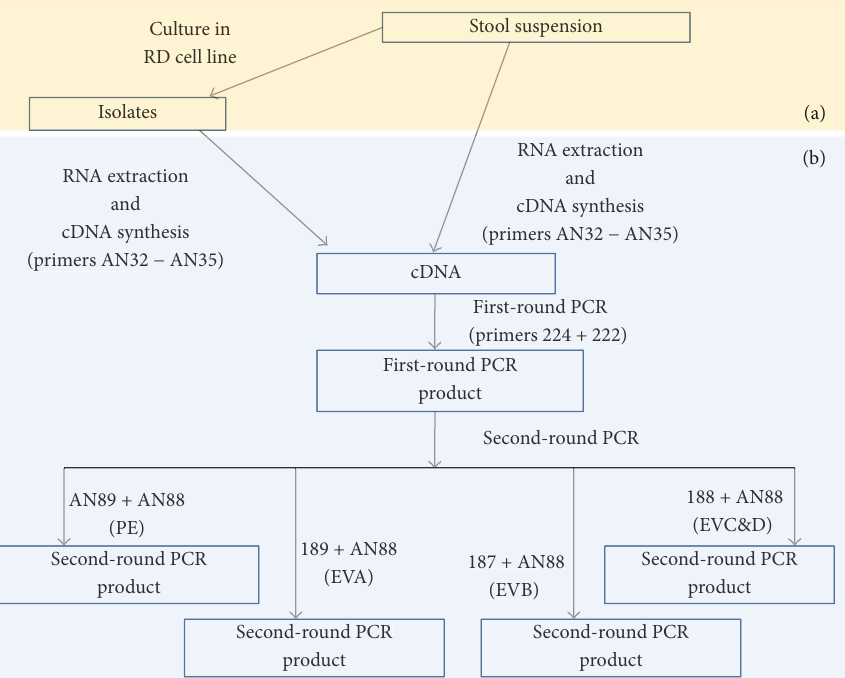
Figure 1: Schematic representation of the algorithm used in this study. (a) Sixteen RD cell culture isolates and their corresponding sixteen fecal suspensions were collected from the WHO National Polio Laboratory in Ibadan, Nigeria. (b) RNA was extracted from all thirty-two (32) samples (RD positive isolates and their corresponding suspension) and subsequently converted to cDNA. The cDNA was used as template in the 1st round PCR assay. The first-round PCR assay product was used as template in four different second-round PCR assays. Positive samples for the 2nd round PCR assays were sequenced and the result was used for enterovirus